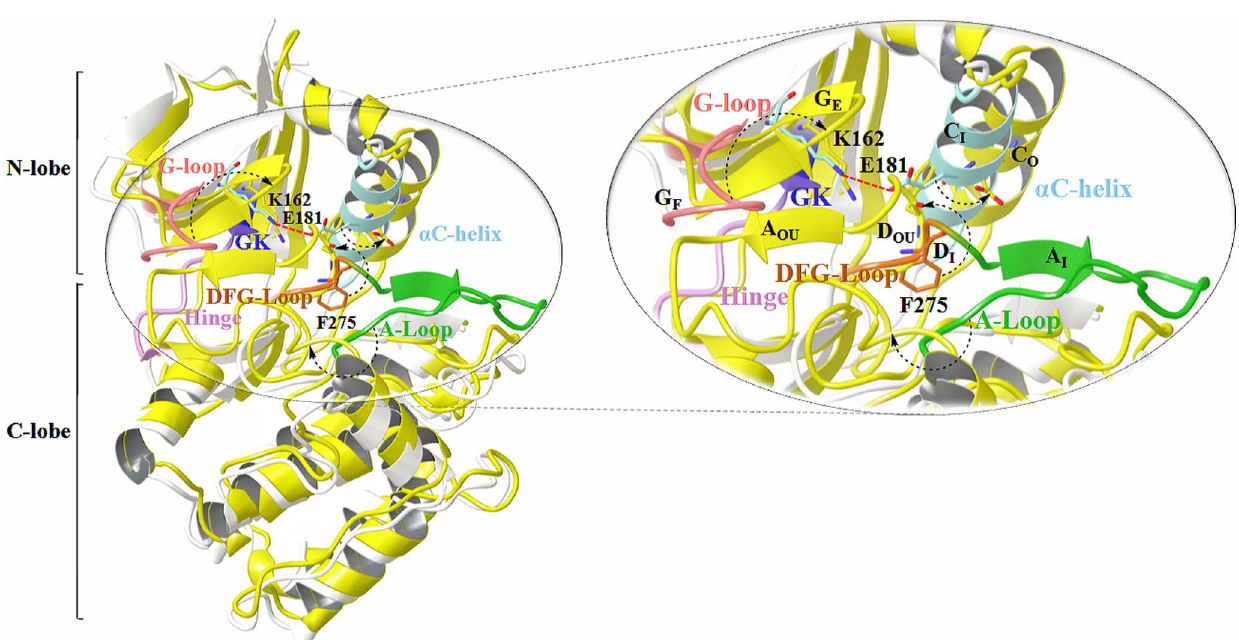
Figure 2. Conformational variations in the major structural motifs of AK concomitant with DFG-flip. In the figure, the two conformations of AK, active DFG-in (PDB: 3E5A, white) and the inactive DFG-out (up) conformation (PDB: 3UNZ, yellow) are superimposed. The major structural motifs of DFG-in are multi-coloured while that of DFG-out (up) are depicted in yellow. The figure displays the key components of the AK kinase active site: G-loop, a C-helix, gatekeeper (GK) hinge, DFG-loop, A-loop; and their critical residues: salt bridge formers Lys162, Glu181 ( a C-helix) and Phe275 (DFG-loop). The arrows depict the differences in the two conformations resulting due to the DFG- and A-loop flip, a C-helix rotation and G-loop folding. The G-loop is in the folded conformation (G F ), a C-helix is in the ’in’ conformation (C I ) and A-loop in ’in’ conformation (A I ) in the DFG-in structure shown in figure while in the DFG-out (up) structure, the G-loop is in the extended form (G E ), a C-helix is in the ’out’ conformation (C O ) and A-loop in ’out (up)’ conformation (A OU ). The co-crystals have been removed for clarity.